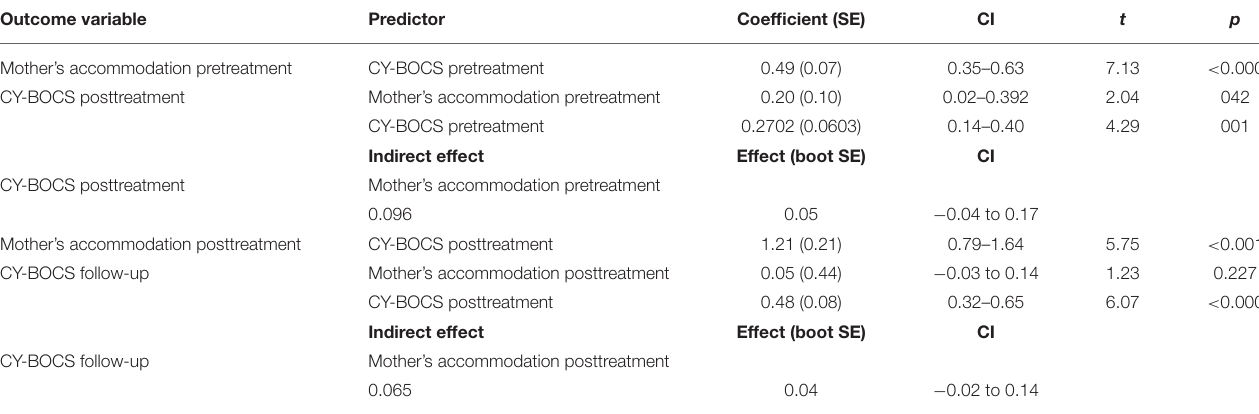
TABLE 5 | Association between CY-BOCS, as mediated by mother’s